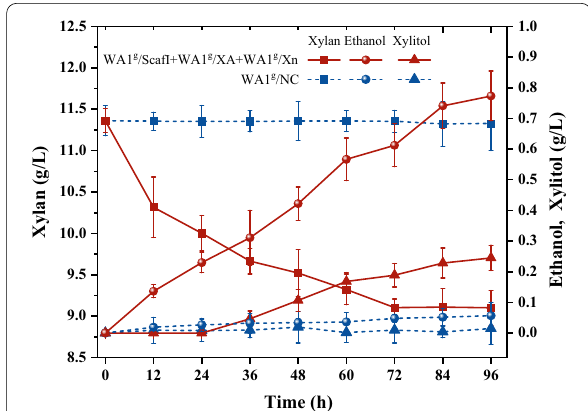
Fig. 5 Time profiles of hydrolysis and ethanol production from birchwood xylan using two chimeric enzymes docking on the designer